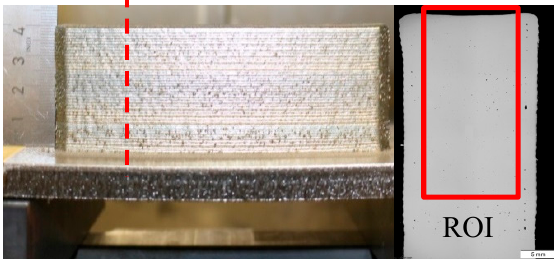
Figure 6. Material sample and the associated cross section.